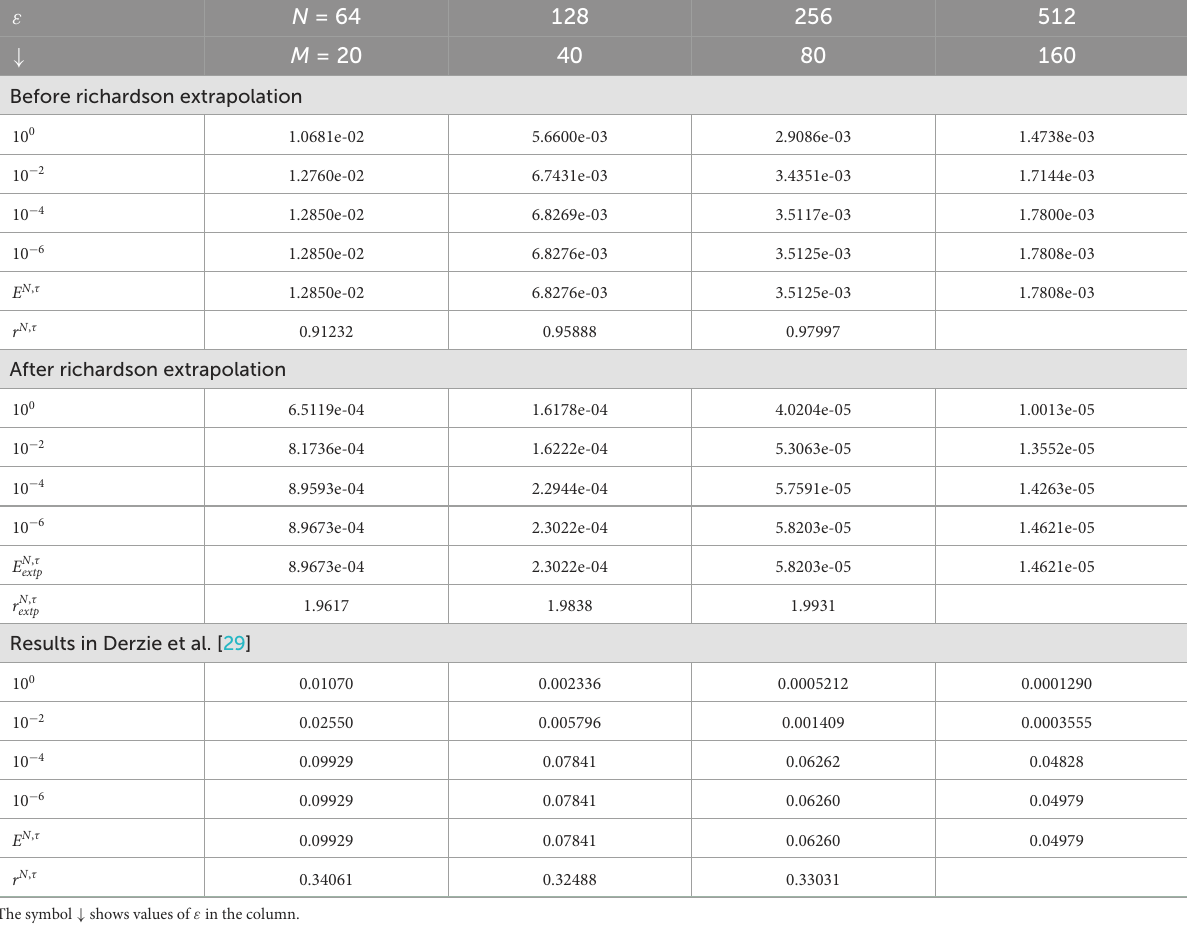
TABLE 4 Comparison of E N , τ ε , E N , τ , r N , τ , ( E N , τ ε ) extp , E N , τ extp , and r N , τ extp for Example 5.4 with results in Derzie et al. [29].